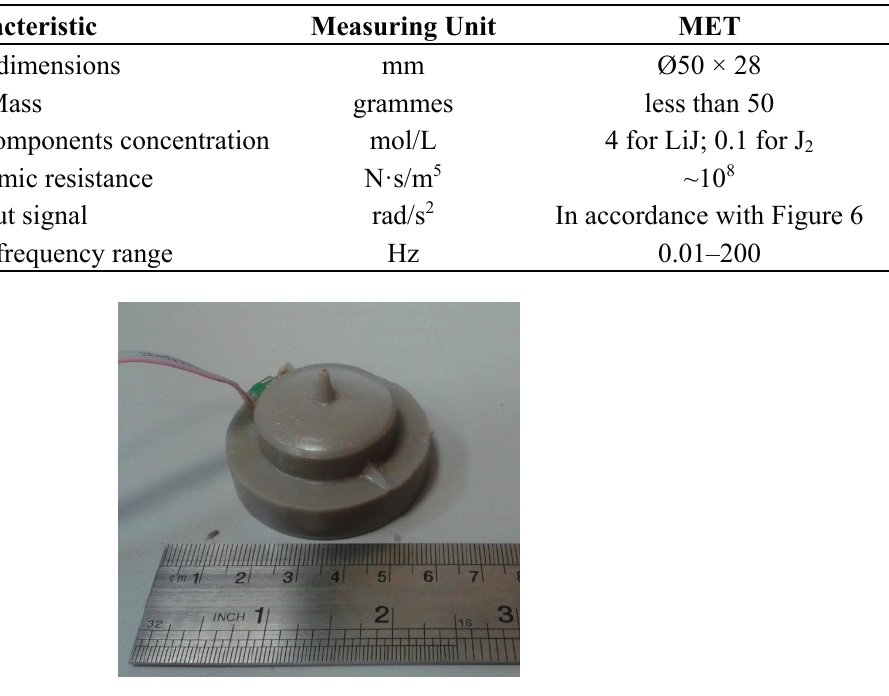
Figure 3. Appearance of a molecular electronic angular motion